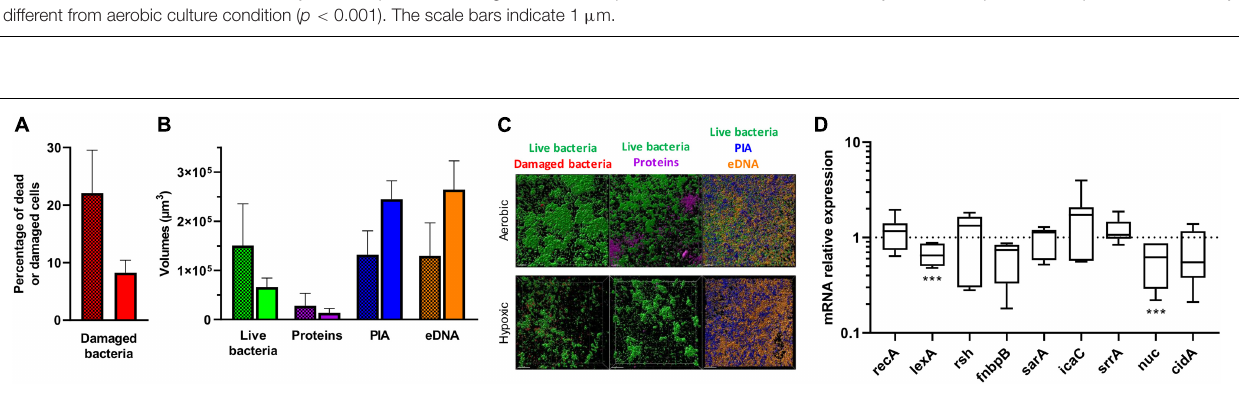
Frontiers in Microbiology |